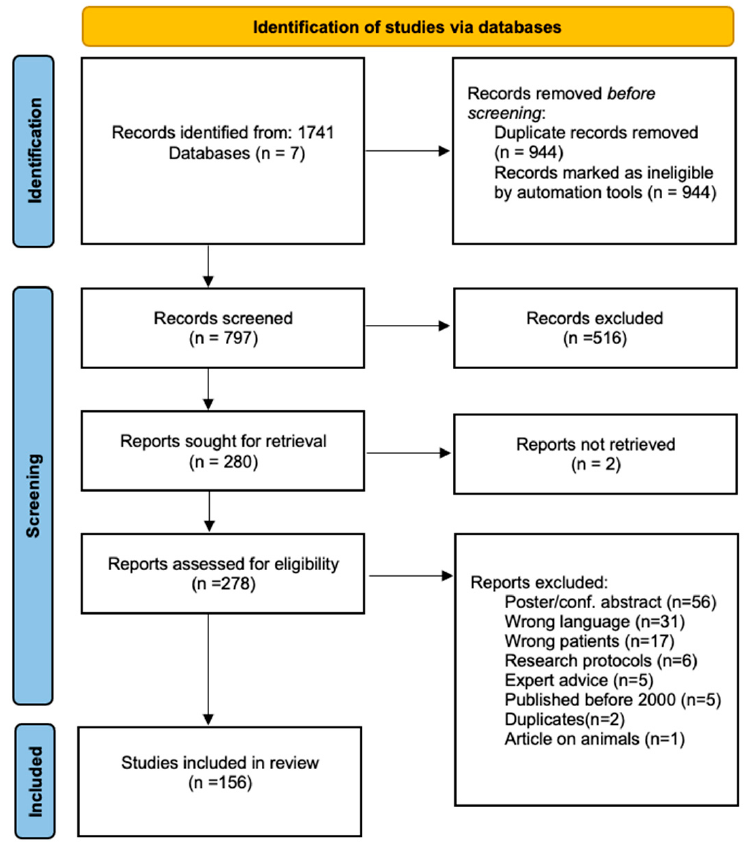
Figure 1. Prisma flow chart showing the identification of studies via databases.